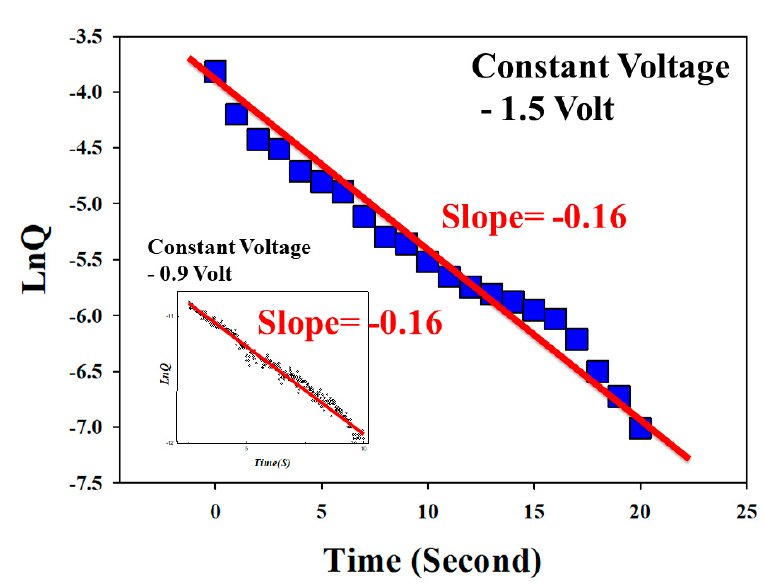
Figure 6. The lnQ-T curves of the vanadium thin film RRAM devices under -0.9V and − 1.5 V con- Figure 6. The ln Q–T curves of the vanadium thin film RRAM devices under − 0.9 V and − 1.5 V stant voltage sampling condition. constant voltage sampling